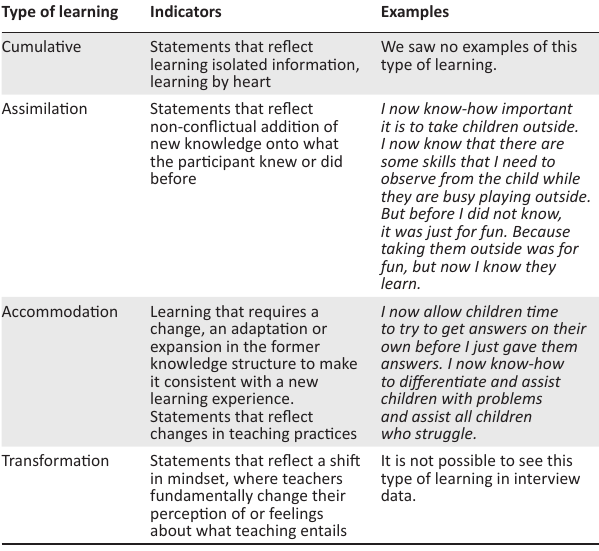
TABLE 1: Types of learning, indicators for the different types of learning and